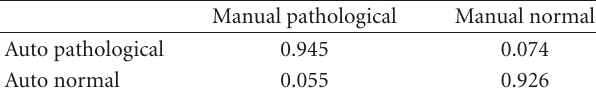
Table 10: Mean confusion matrix for the 10 test sets (Two correlations case).